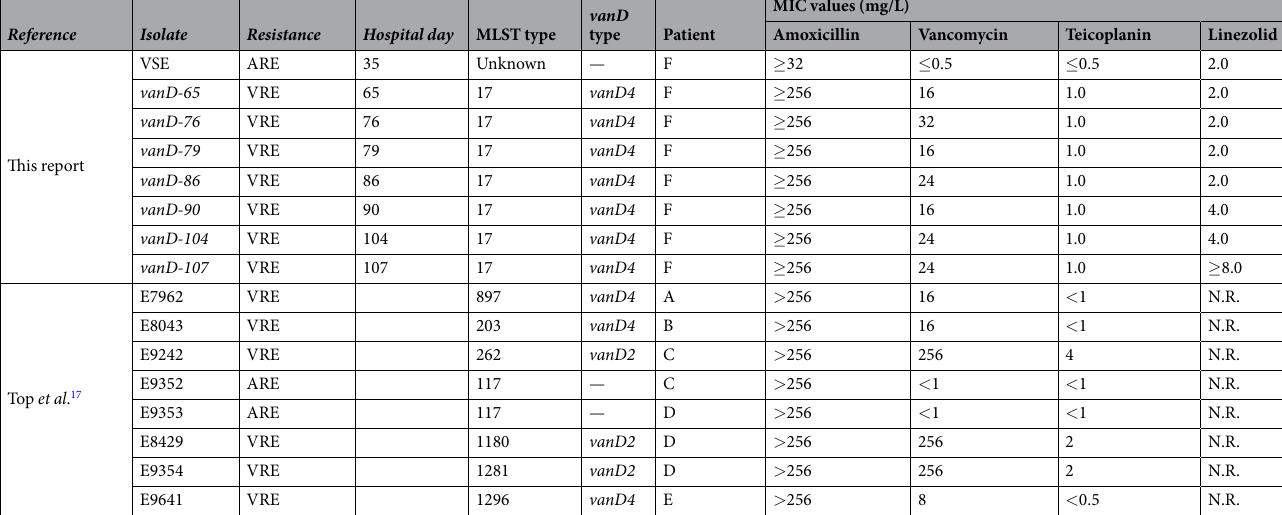
Table 1. An overview of various characteristics of the vanD -positive Enterococcus faecium described in this report and the six previously described Dutch vanD -positive E . faecium isolates. Shown are MLST types, vanD subtypes and the MIC values for amoxicillin, vancomycin, teicoplanin, linezolid. MIC values for this report were determined by E-test for isolates 65–107. Only VITEK II data is known for the vancomycin-susceptible isolate of hospital day 35. The VRE isolates of day 65 through day 107 were re-evaluated by E-test (Shown is median of 3 independent measurements). VSE: vancomycin susceptible enterococcus, VRE: